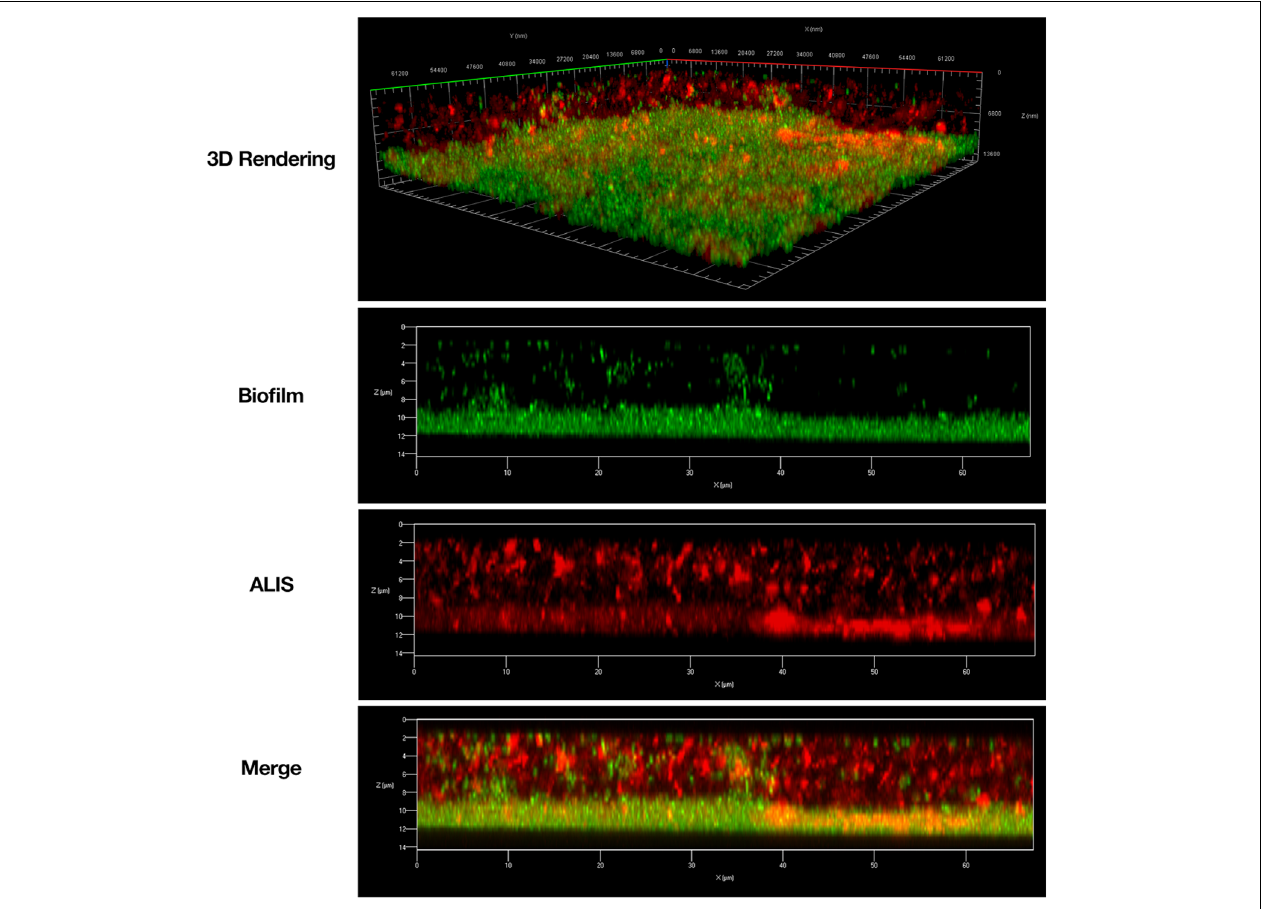
FIGURE 1 | Amikacin liposome inhalation suspension (ALIS) penetrated Mycobacterium avium biofilms. Biofilms (strain A5) were established for 7 days in 2-well chamber slides, treated with 512 µ g/mL of AF657-labeled ALIS (red) for 4 h, fixed, stained with Syto9 (green), and imaged with a Zeiss LSM 780 confocal scanning microscope (630 ×